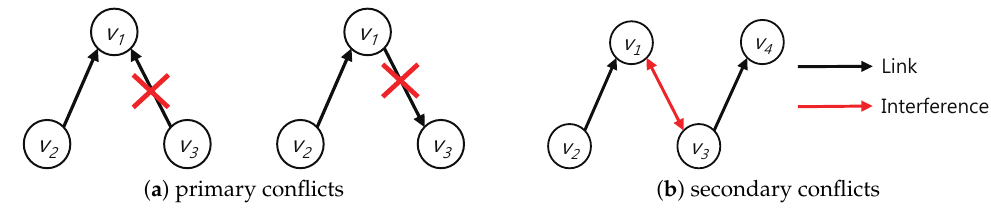
Figure 8. Conflicts in TDMA wireless